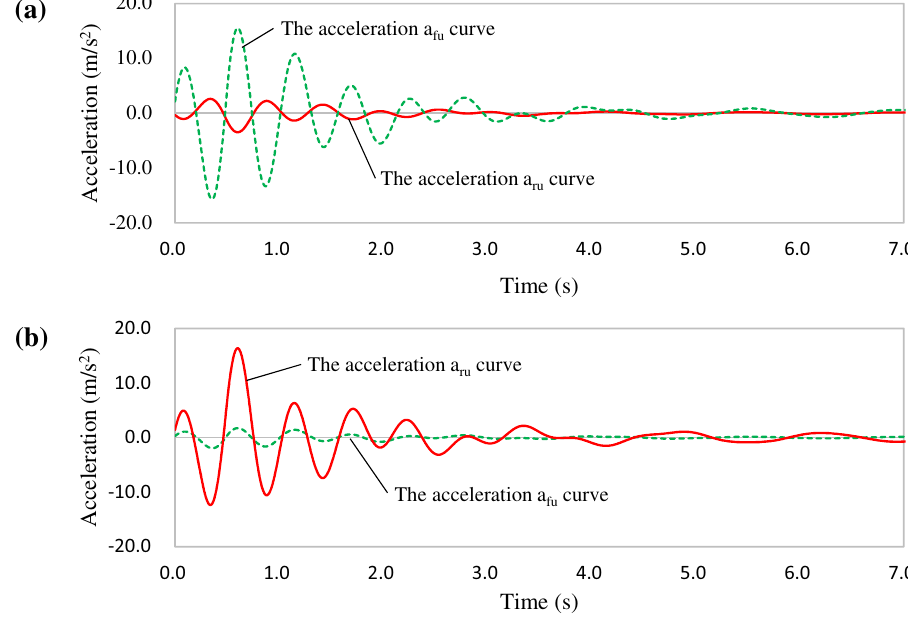
Fig. 7 Vibration test data in improved state. a Acceleration data under front wheel excita- tion. b Acceleration data under rear wheel